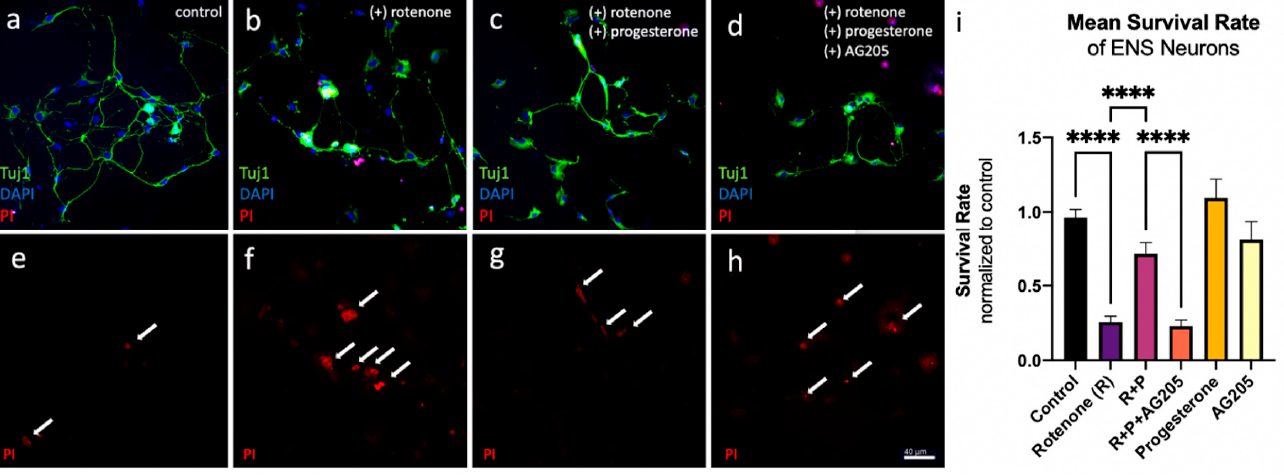
Figure 4. Confocal laser scanning microscopy of isolated plexus myenteric cells from male Wistar rats at p15 under different treatment conditions: ( a , e ) controls, ( b , f ) 1 nM rotenone, ( c , g ) 1 nM rotenone plus 10 nM progesterone, ( d , h ) 1 nM rotenone, 10 nM progesterone plus 5 nM AG205. ( a – d ) ENS neurons are marked in green (Tuj-1). ( e – h ) ENS neurons showing a positive PI signal (red) were counted as dead (white arrows). Scale bar: 40 µm. ( i ) Analysis of mean survival of ENS neurons treated for 24 h with rotenone (1 nM) with or without progesterone (10 nM) or AG205 (5 nM). Each experiment was performed in a blinded fashion. A total of 7415 cells were counted on 282 coverslips in 4 independent experiments. Statistical analysis was performed with GraphPad Prims software, using one-way ANOVA with a Tukey’s multiple comparison test, p < 0.0001 (****). Data are shown as mean ± SEM ( N = 4).